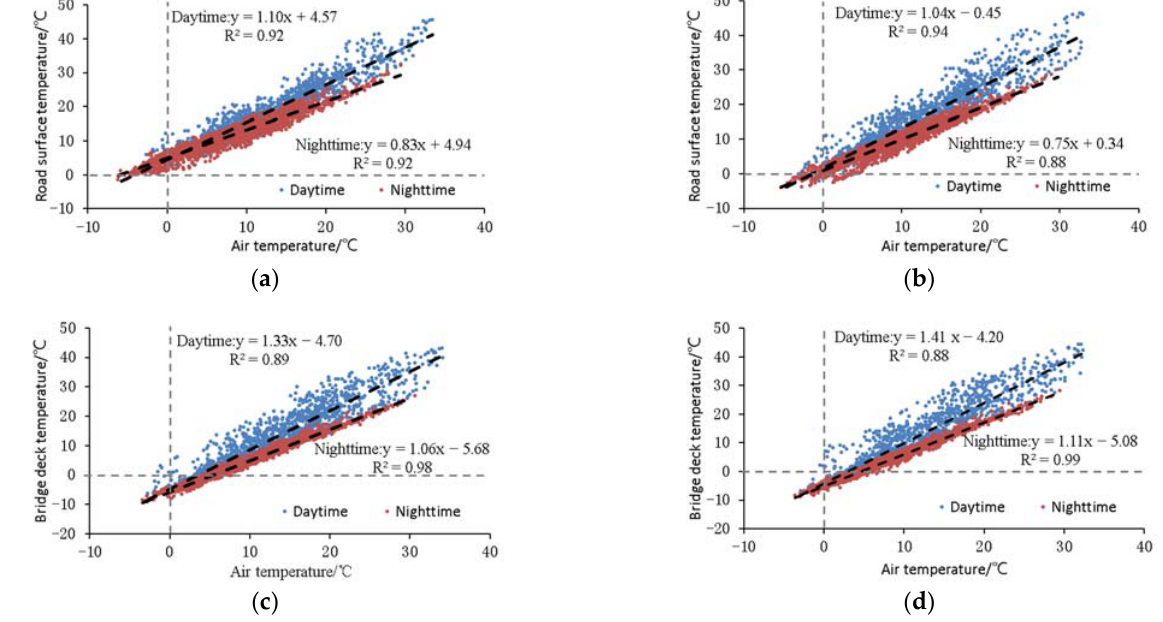
Figure 2. Distribution of road surface (bridge deck) temperature against air temperature at road surface station 1 ( a ), road surface station 2 ( b ), bridge deck station 1 ( c ) and bridge deck station 2 ( d ) ( ● represents daytime; ● represents nighttime; unit: °C).